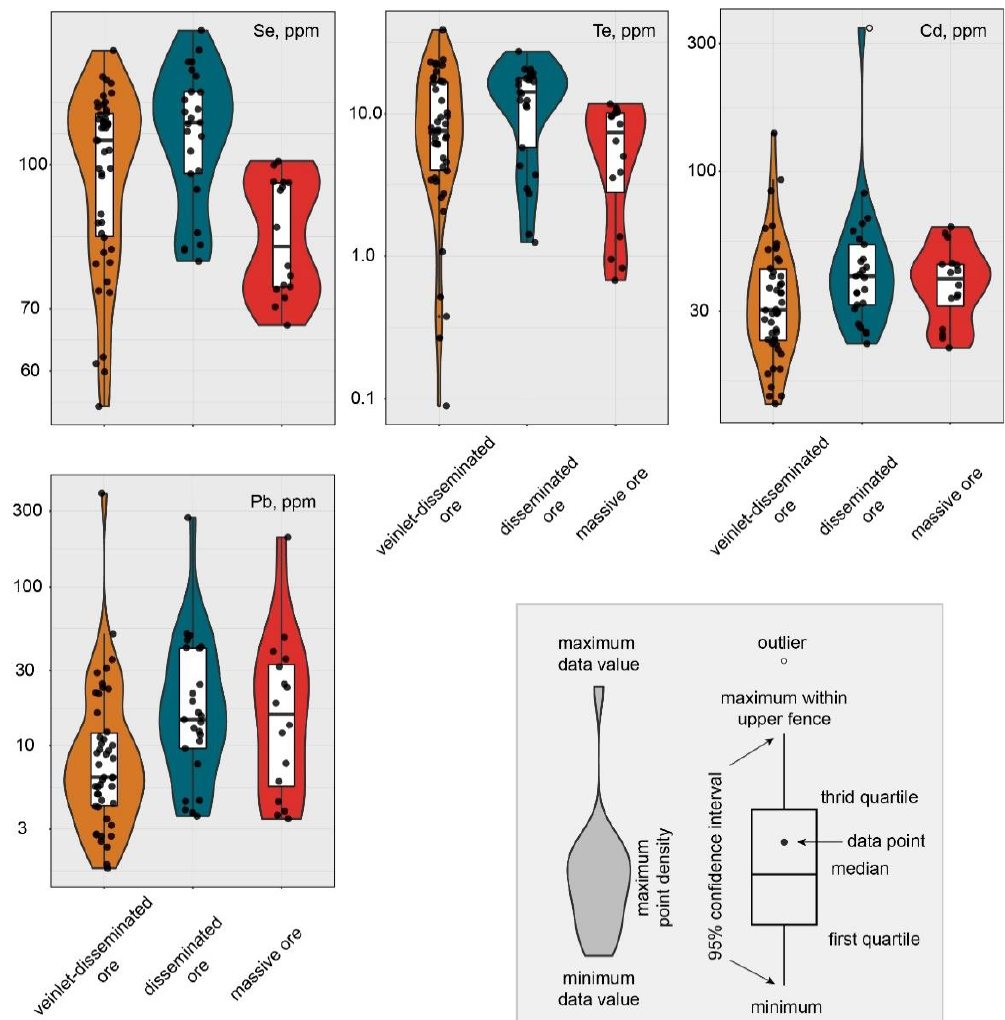
Figure 5. An example of violin plots for Se, Te, Cd, and Pb concentrations determined in chalcopyrite of the three ore types of the Oktyabrsk deposit. An explanation of the violin plot is in the low right-hand of the figure. Violin plots for other elements are shown in the Supplementary Figure S1. Colors are the same as in Figure 1b for the ore types.